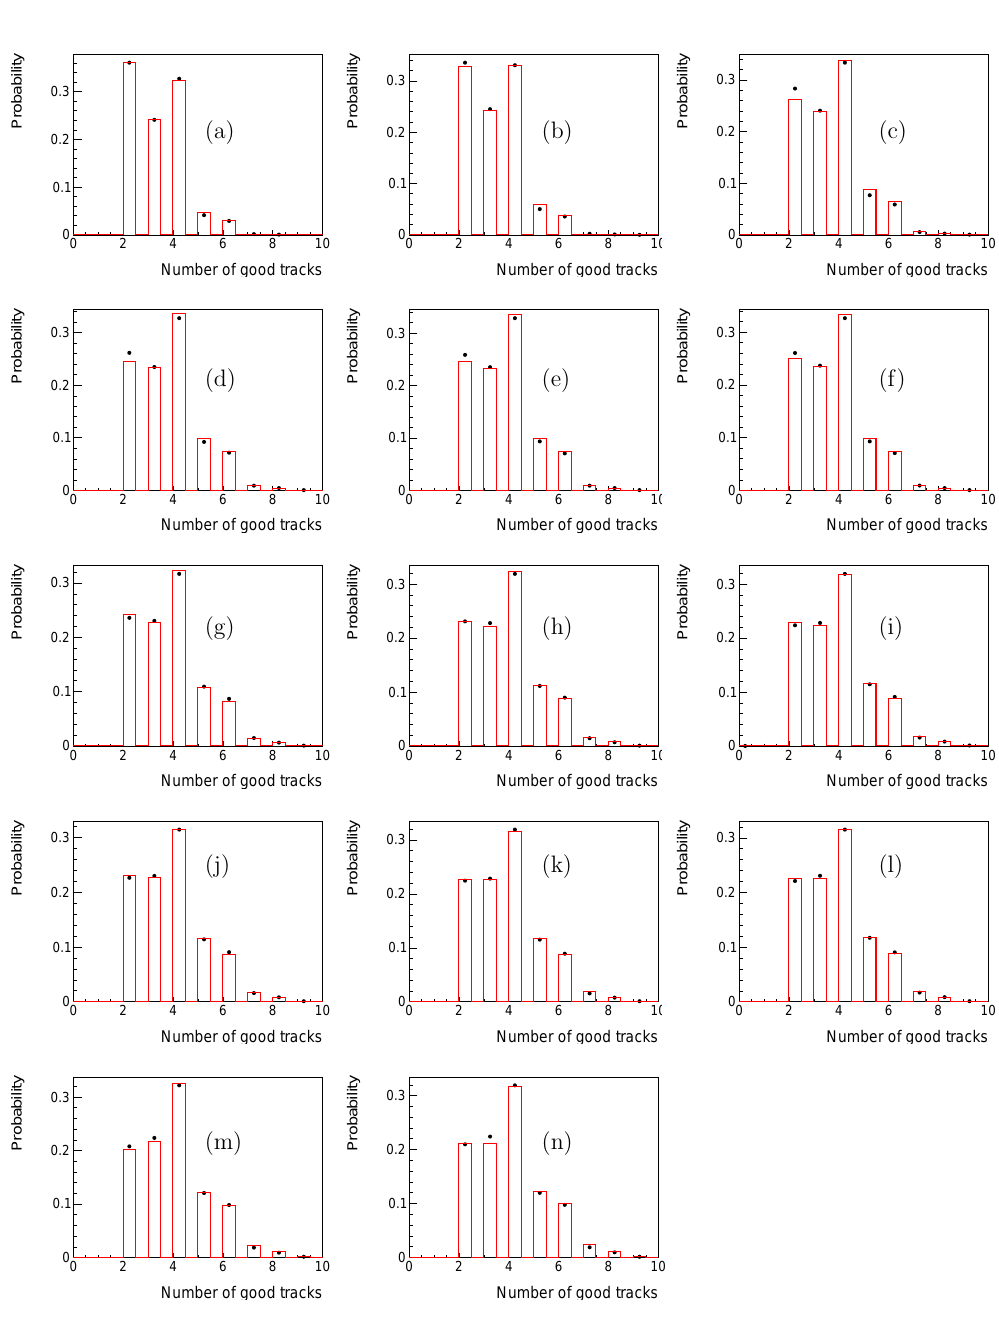
Figure 2. (color online) Comparison of distributions between data and MC for the number of charged tracks at (a) 2.2324 GeV, (b) 2.4000 GeV, (c) 2.8000 GeV, (d) 3.0500 GeV, (e) 3.0600 GeV, (f) 3.0800 GeV, (g) 3.400 GeV, (h) 3.500 GeV, (i) 3.5424 GeV, (j) 3.5538 GeV, (k) 3.5611 GeV, (l) 3.6002 GeV, (m) 3.6500 GeV, (n) 3.6710 GeV. The dots denote data, and the open bars denote